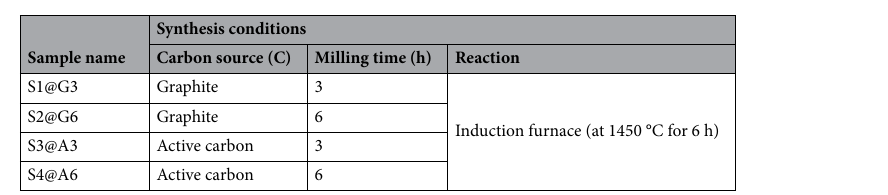
Figure 1. Schematic representation of the B 4 C synthesis experiment.